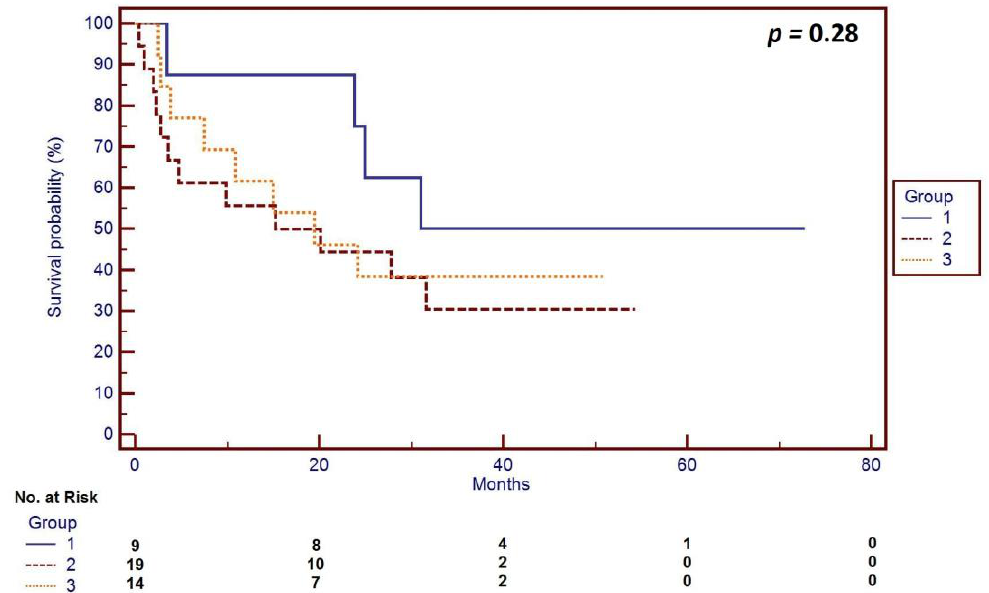
Figure 2. Survival curves corresponding with the degree of residual disease following TC during primary debulking surgery for OC according to the completeness of cytoreductive (CC) surgery (using Sugarbaker’s completeness of cytoreduction score [15]): Group 1—patients ( n = 9) with no residual disease (CC = 0), median overall survival (mOS) of 45.1 months (range 3.8–56.7); Group 2—patients ( n = 19) with nodules below 2.5 mm after surgery (CC-1), mOS of 11.1 months (0.9–72.7); Group 3—patients ( n = 14) with nodules between 2.5 mm and 2.5 cm (CC = 2), mOS of 20.0 months (0.4–48.5); p = 0.26. Table 2. Theanalysisofadverseeventsandperioperativeoutcomesamongpatientstreatedwithtotalcolectomyfor ovarian cancer. Adverse